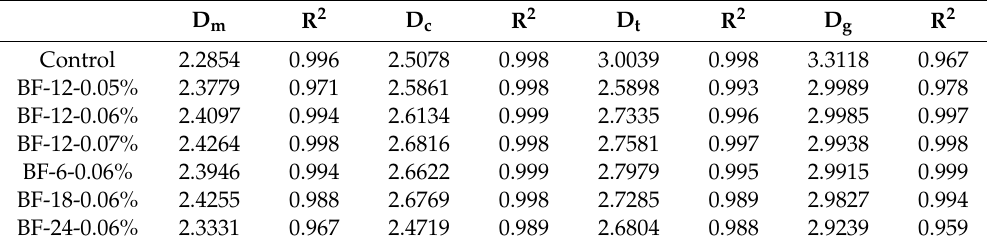
Figure 10. Calculation of fractal dimension of BF-6-0.06% in four regions. Table 5. Results of fractal dimension of BFRCs in four regions.